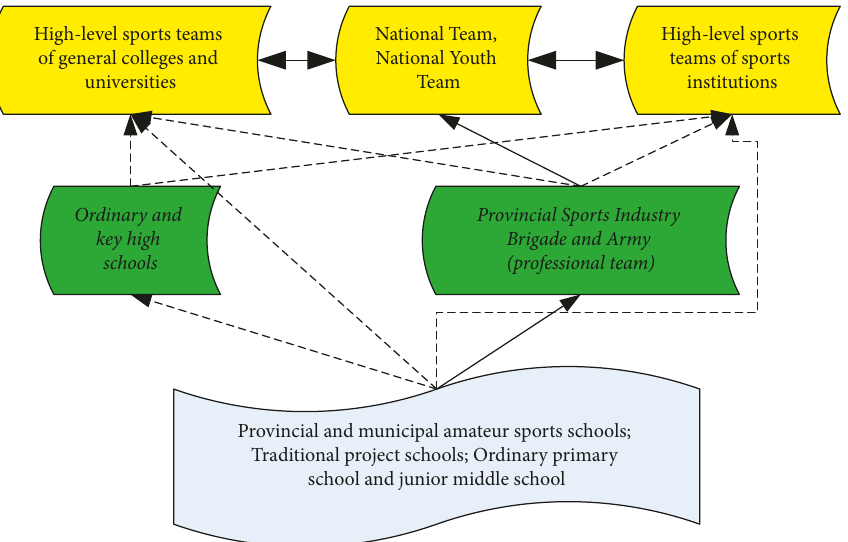
Figure 2: China’s competitive sports talent training pathway map.